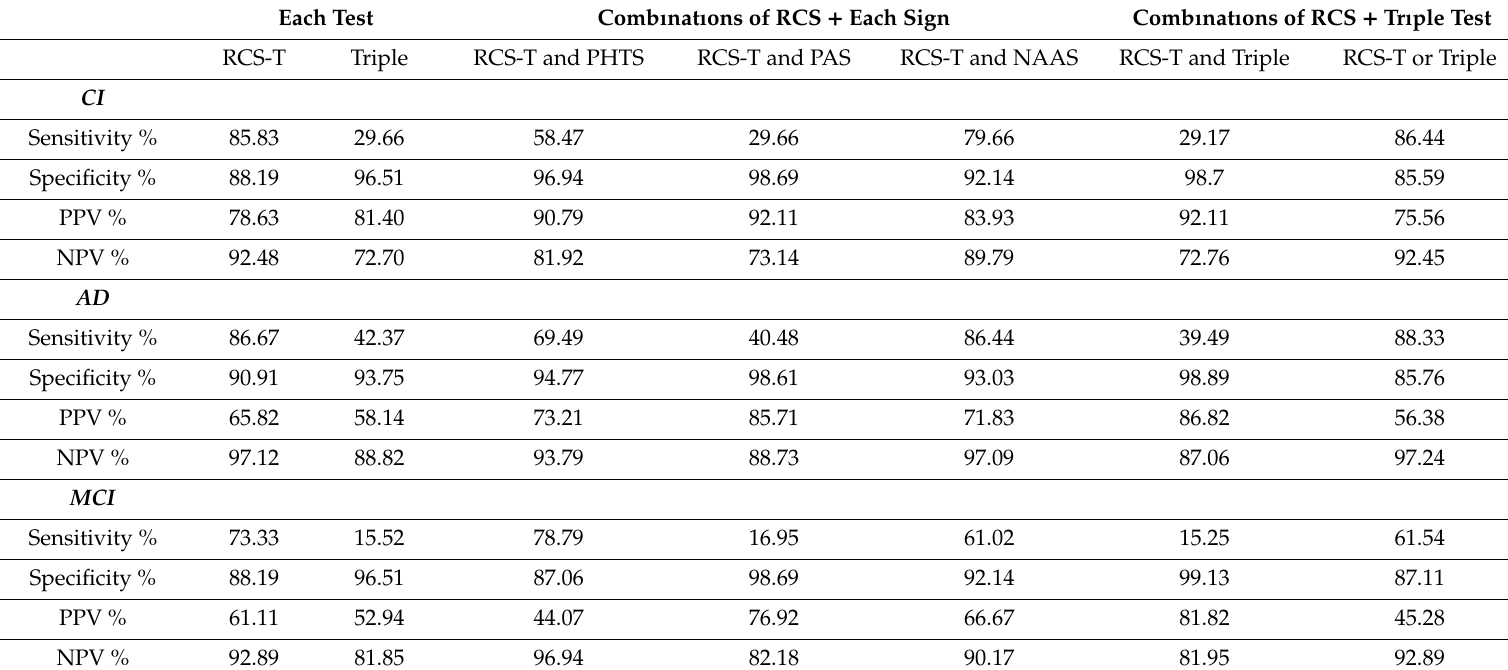
Table 2. Assessment of the diagnostic value of the RCS-T and Triple Test individually and the combination of RCS-T with each sign and Triple